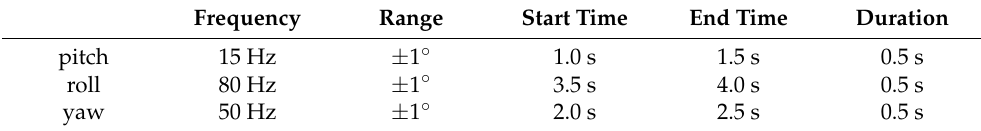
Table 2. The change in attitude of the plane.